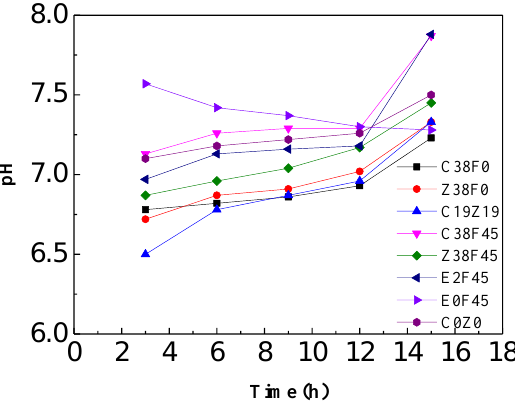
Figure 5. pH changes of different groups.